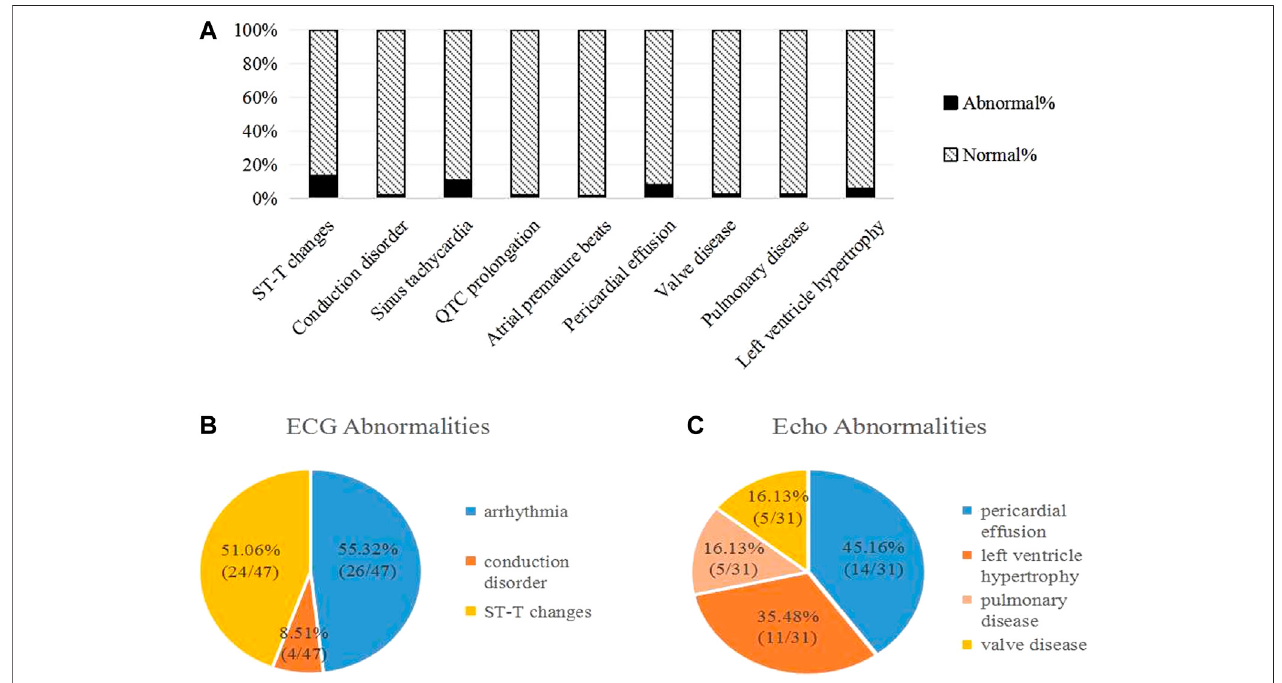
FIGURE 5 | Abnormalities of subclinical cardiac disorders in ALL children during the fi rst year of chemotherapy. (A) Abnormalities on ECG and Echo; (B) ECG Abnormalities; (C) Echo Abnormalities. Some patients had more than one of above changes on ECG/Echo.